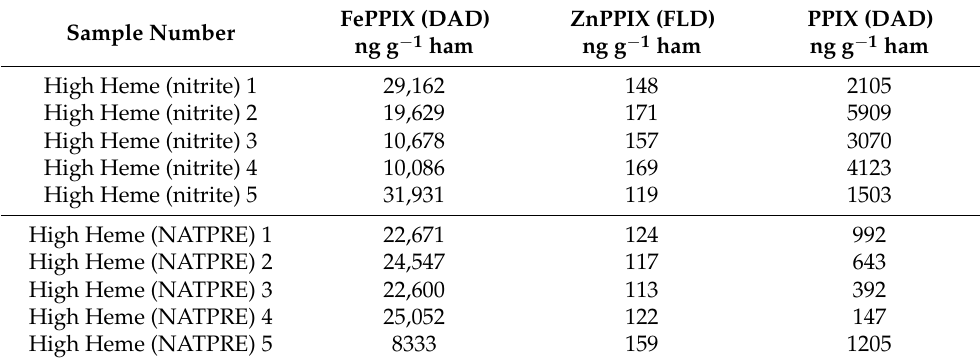
Table 3. Concentration of protoporphyrins in individual cooked hams made with nitrites or with a nitrite-free alternative (NATPRE T-10 HT